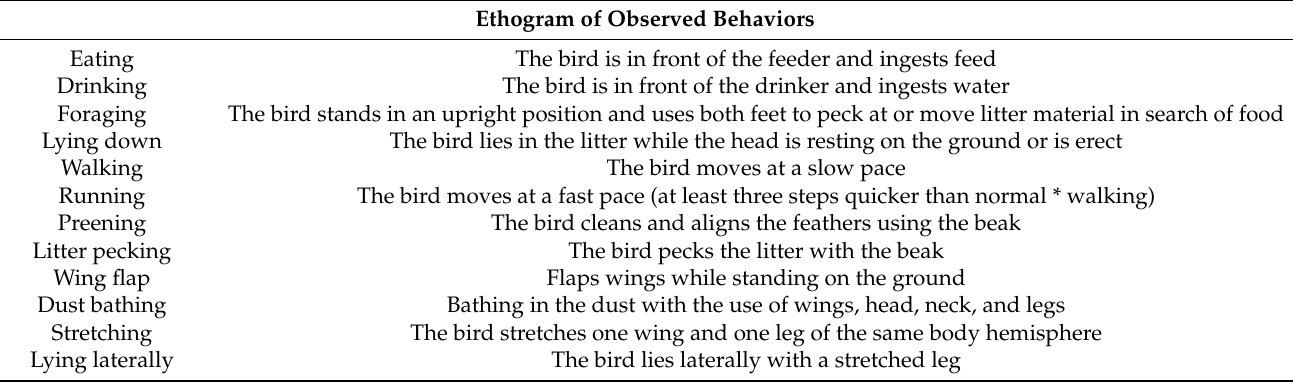
Table 3. Descriptive ethogram of the 12 observed broiler behaviors for the composition of the data set. Ethogram of Observed